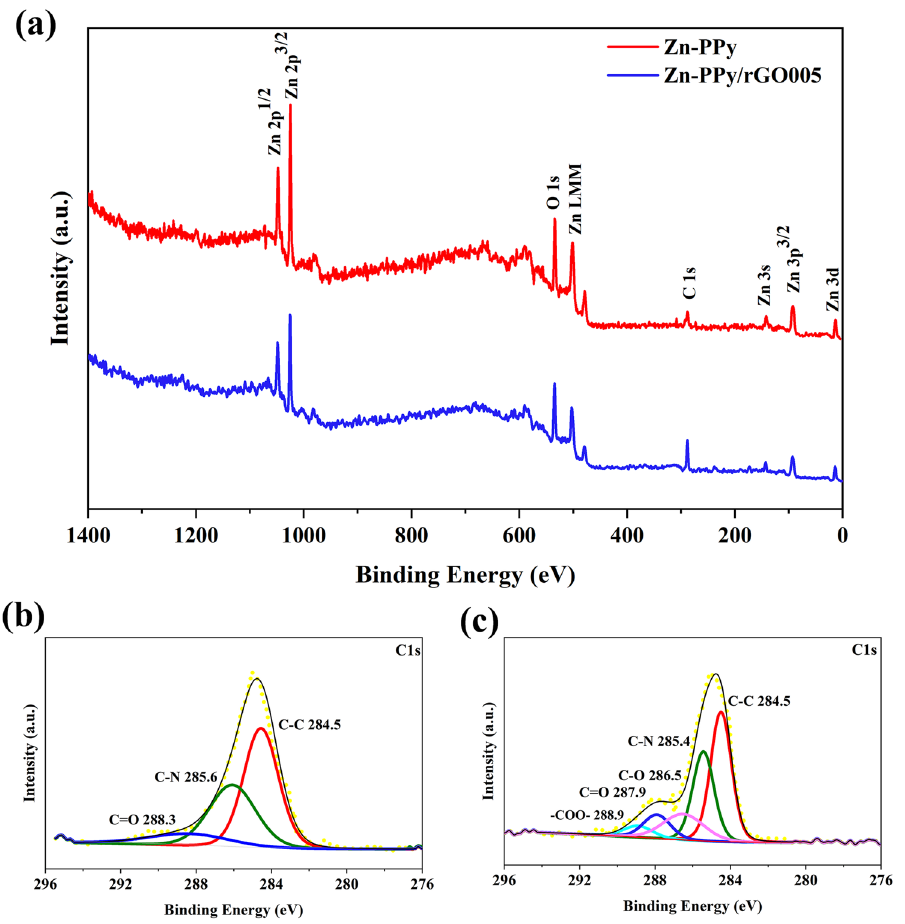
Figure 4. ( a ) XPS survey spectrum of samples ( b ) C1s spectra of Zn-PPy, and ( c ) C1s spectra of Zn-PPy/